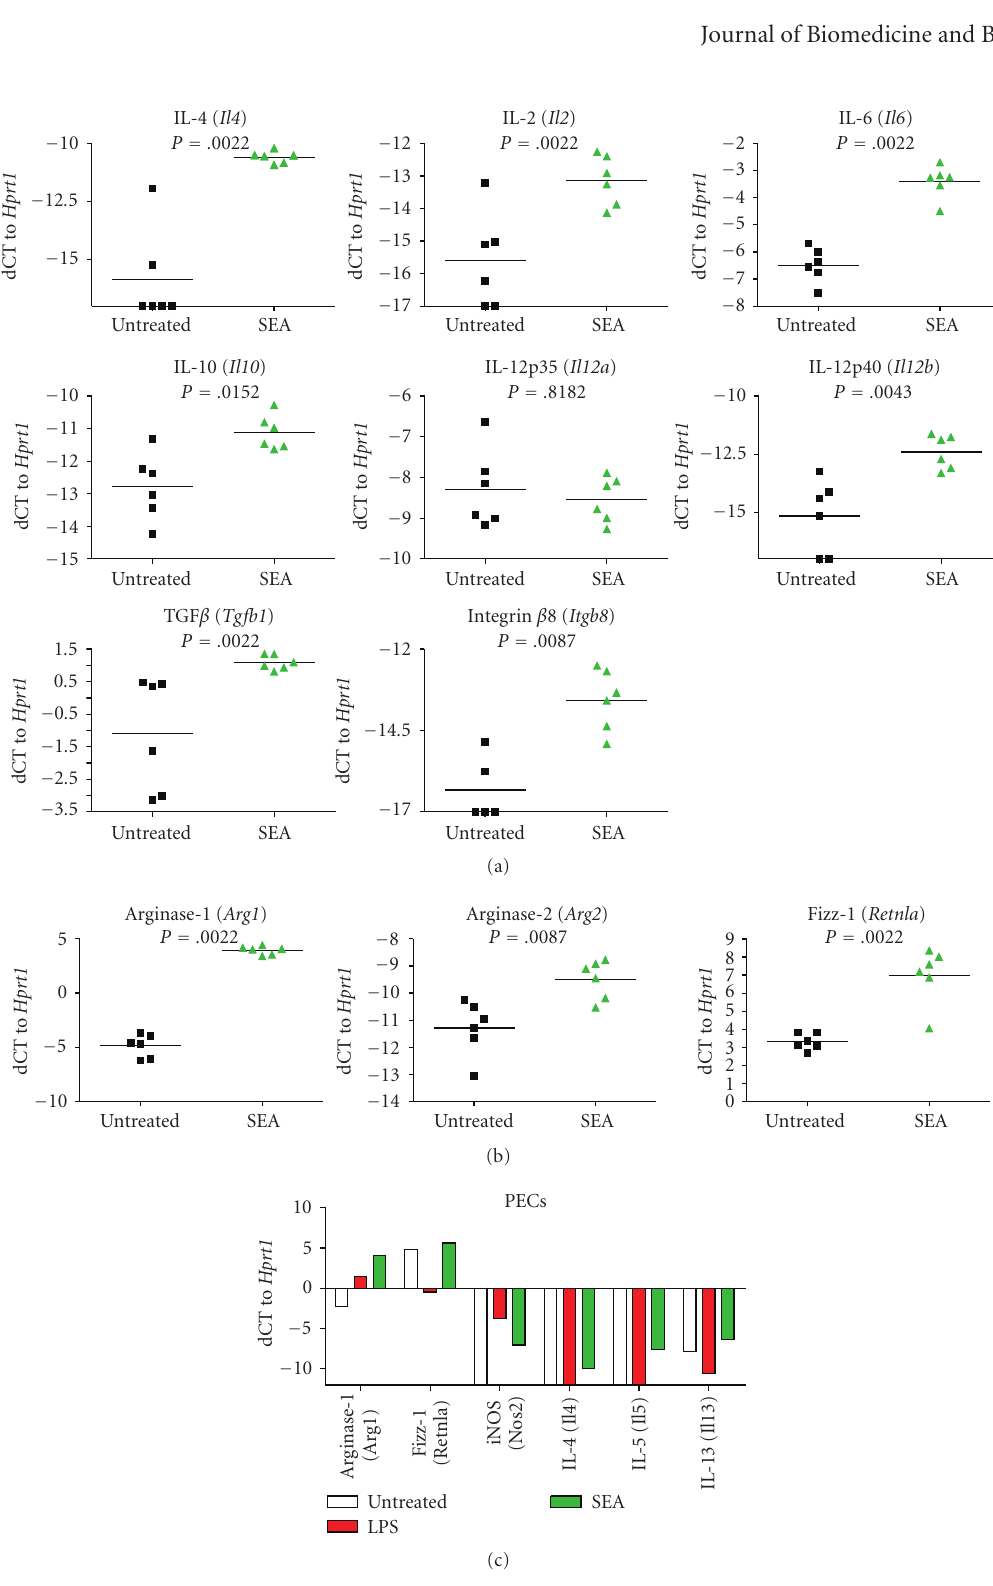
Figure 2: Schistosome antigens alternatively activate M Φ s in vivo. (a) Increased expression of anti-inflammatory cytokines and mediators in the peritoneal cavity following SEA treatment of NOD mice are illustrated. (b) Induction of arginase and Fizz-1, markers of M Φ alternative activation in PECs is given. (c) Alternative activation in response to S. mansoni antigens shows a distinct pattern from that of the classical activation seen in response to LPS. Six-week-old female NOD mice were injected i.p. with 50 μ g SEA or 10 μ g LPS on day 0 and day 7, and PECs were collected for FACS and RT-qPCR analysis on day 10. Data shown are the responses of six mice per group for (a) and (b) or one mouse per condition for (c). Statistical analysis by Mann Whitney U test,